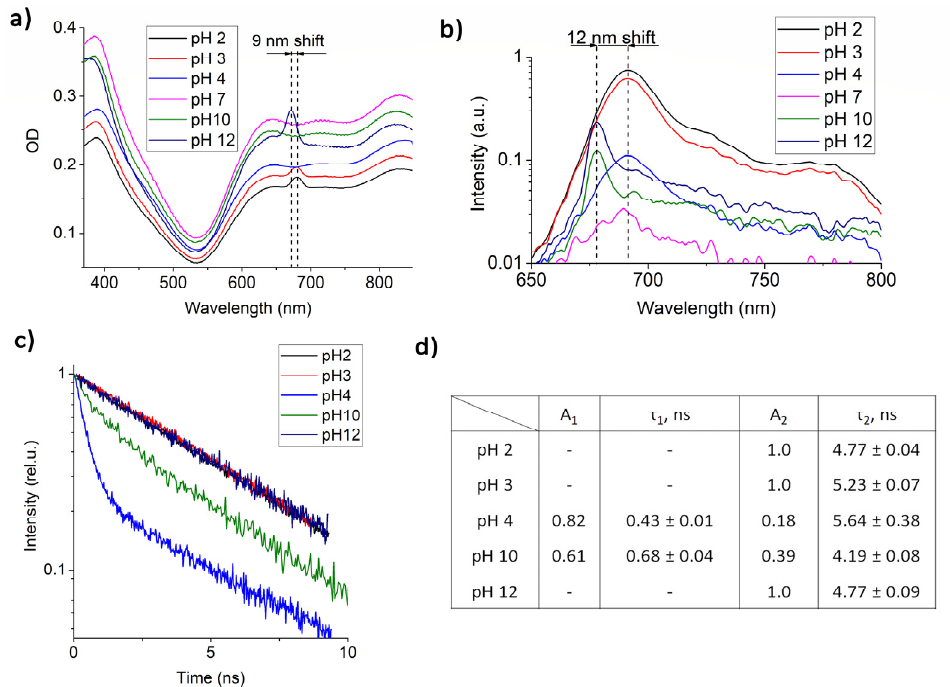
Figure 2. ( a ) AlPc NP absorption spectra at different pH; ( b ) AlPc NP fluorescence spectra (excitation at 633 nm) at different pH (due to the large difference in fluorescence intensity, the spectra are shown on a logarithmic scale); ( c ) AlPc NP fluorescence kinetics at different pH ( d ) calculated fluorescence lifetimes and amplitudes.